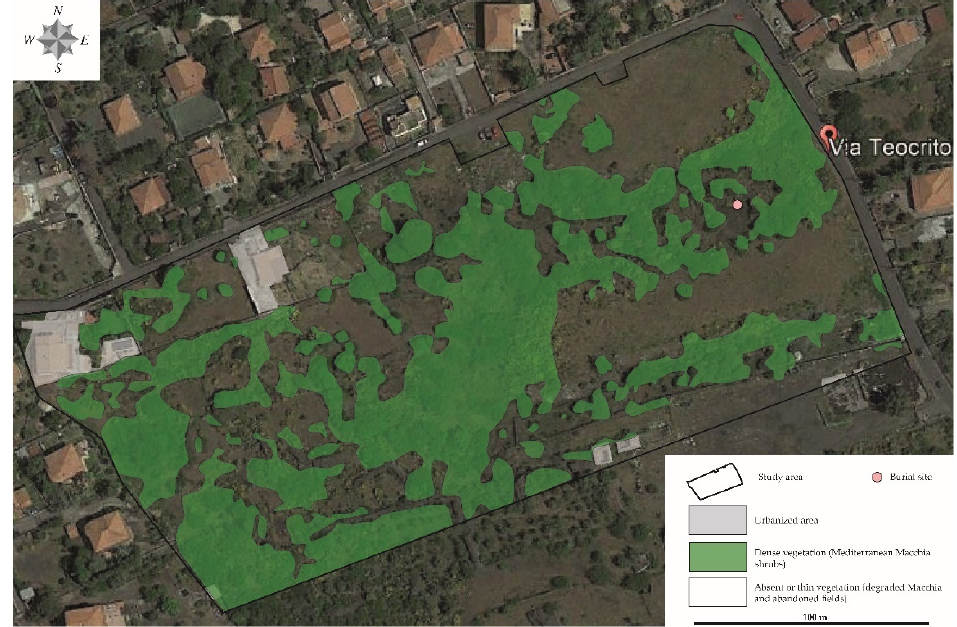
Figure 8. Vegetation and land-use map showing the distribution of the dense vegetation. Photograms captured by videos of the burial sites [43,99] allowed to observe in particular three main grape vine plants surrounding the burial site. The site appeared attached and in front of an isolated small grape vine plant, NW of another isolated grape vine plant, and to the north of a man-made volcanic block circle, containing a flourishing grape vine plant.